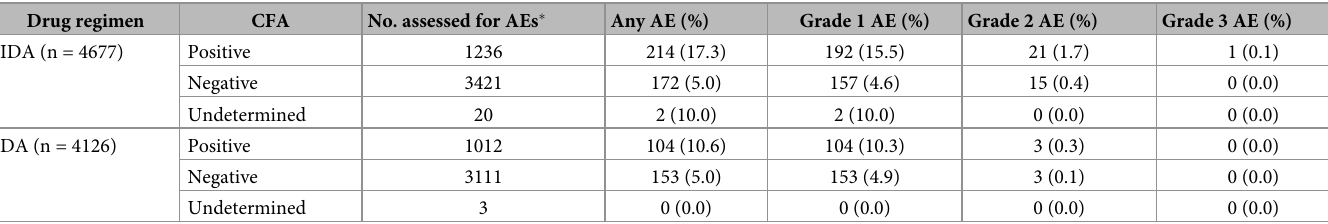
Table 6. Adverse events by circulating filarial antigenemia (CFA) status and treatment regimens. No AE’s beyond Grade 3 were observed. Drug